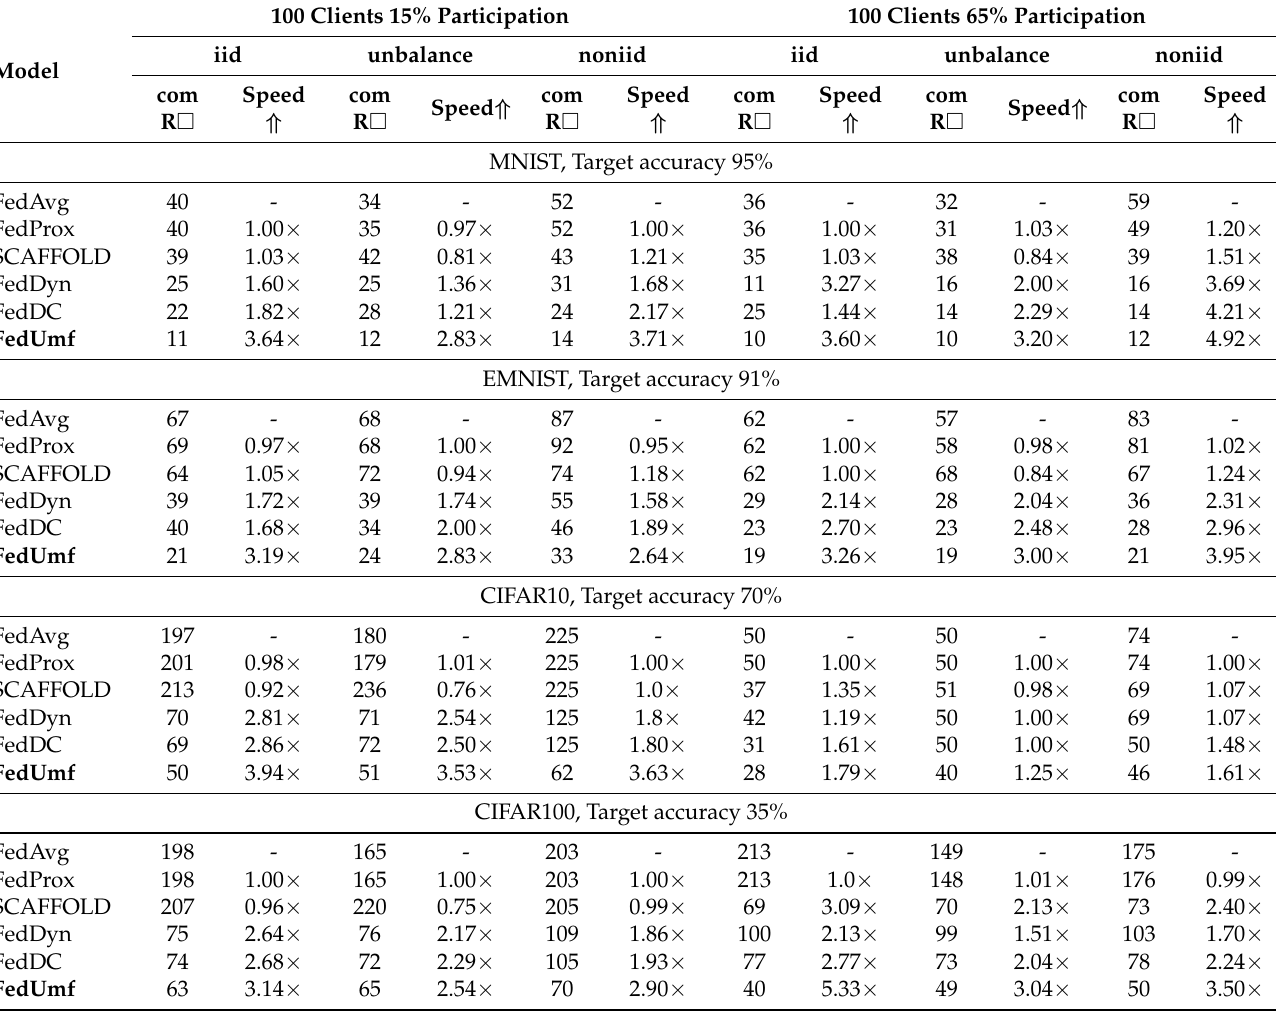
Table A2. Different strategies are used to achieve the specified accuracy. Includes one IID setting, one unbalanced setting, and the non-IID setting. The non-IID Dirichlet coefficient is set to 0.6. com R (cid:3) indicates the communication rounds that reach the target. Speed ⇑ indicates acceleration relative to